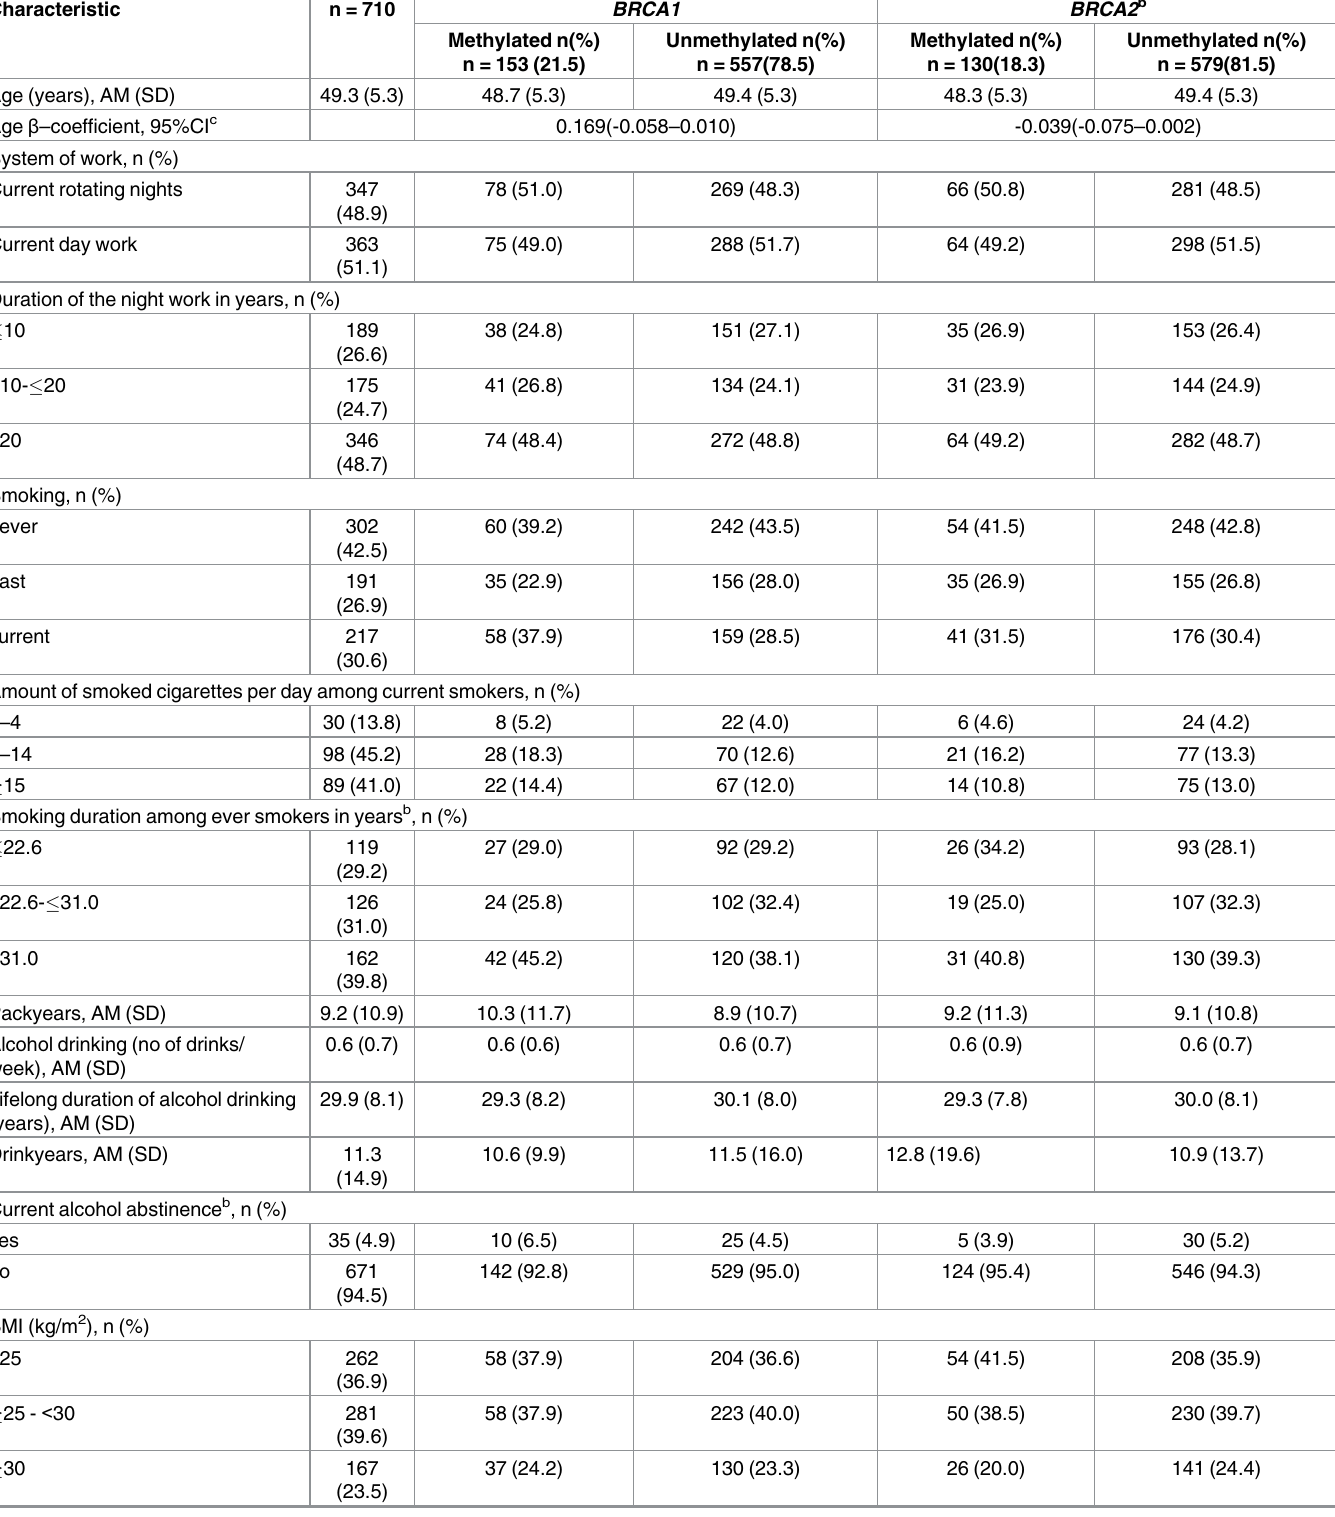
Table 1. Selected characteristics of the studied population of nurses and midwives in the cross-sectional